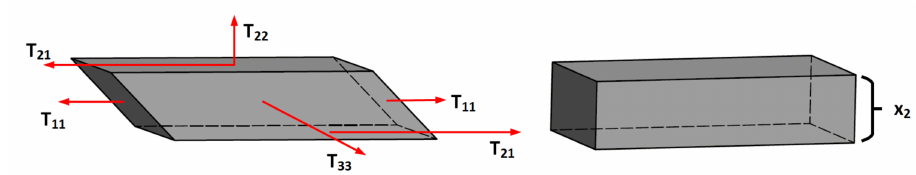
Figure 1. Shear and normal stresses acting on the viscoelastic element [taken from